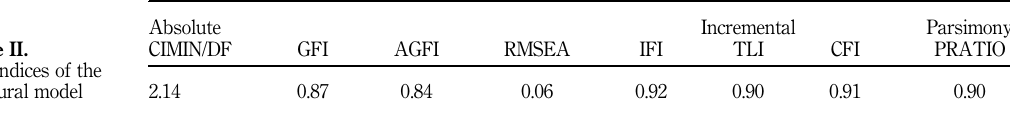
Table II. GOF indices of the structural